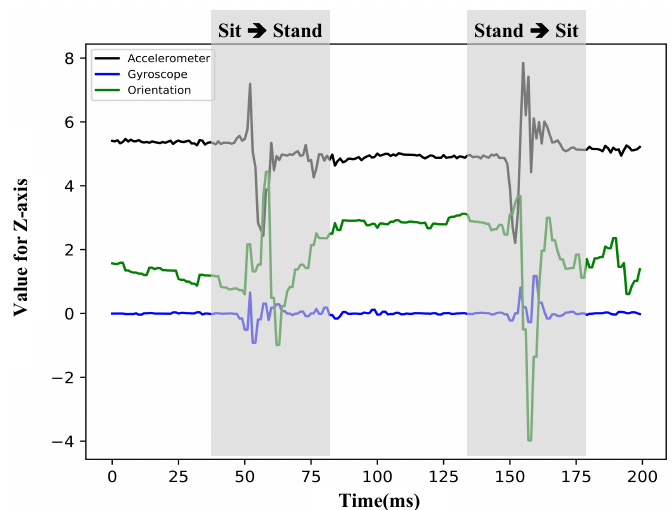
Figure 4. Change in the Z-axis for each type of sensory